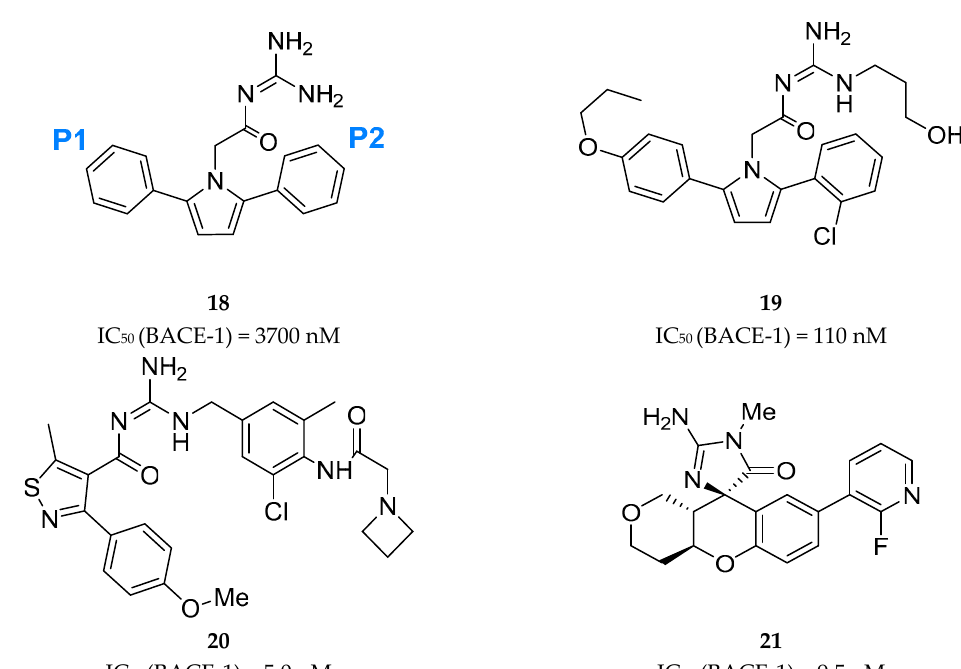
Figure 16. Structures and activity of acyl guanidine-based BACE-1 inhibitors 18–21 .